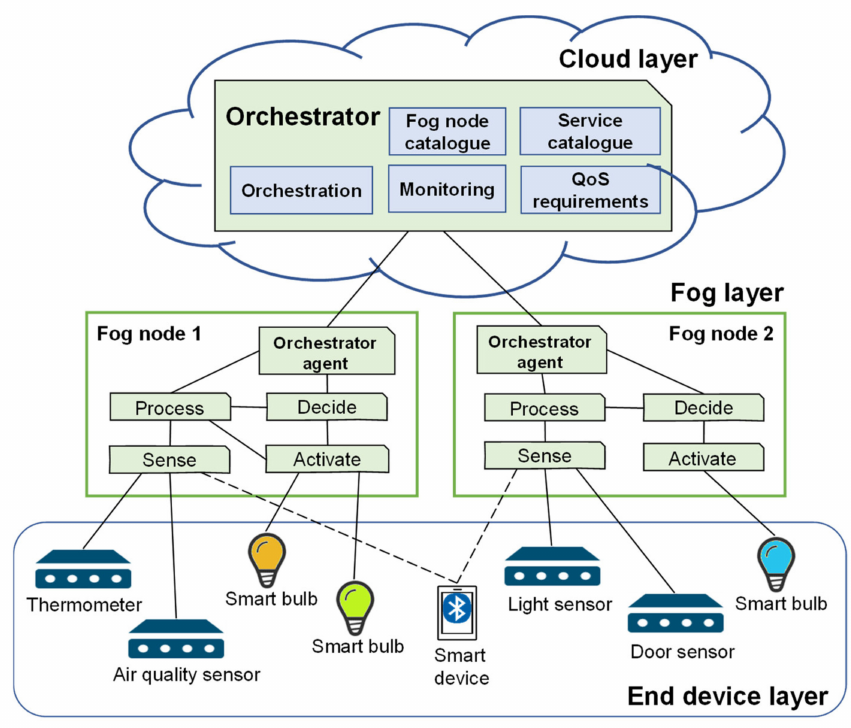
Figure 2. Fog orchestrator architecture and components.